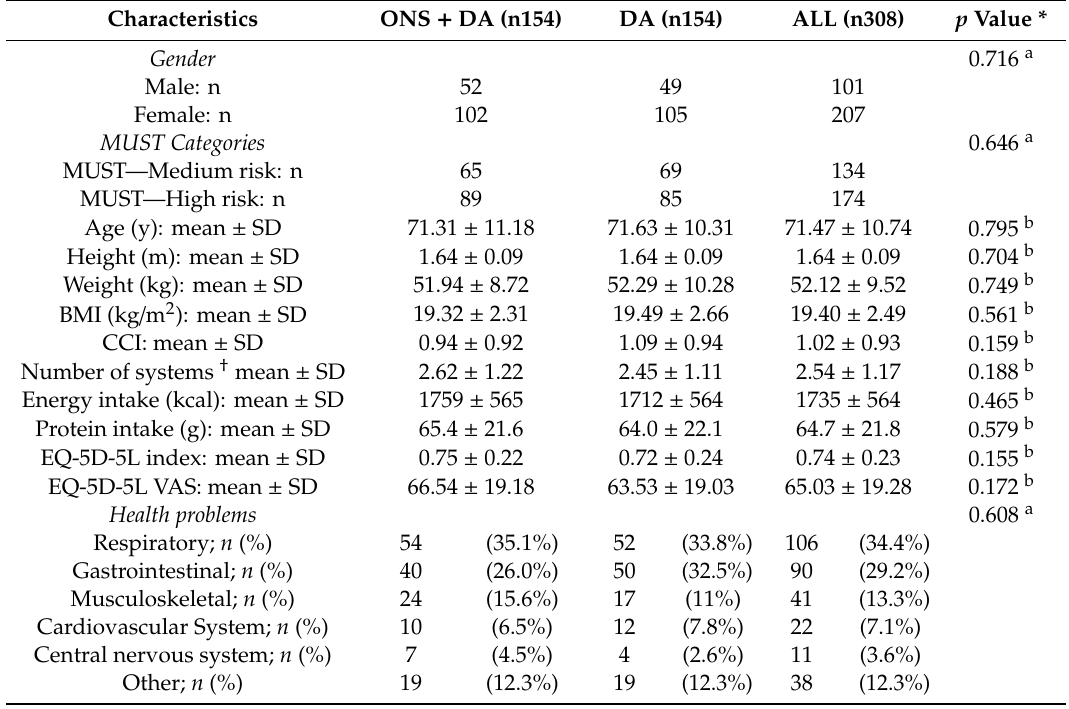
Table 1. Subject characteristics at baseline according to type of